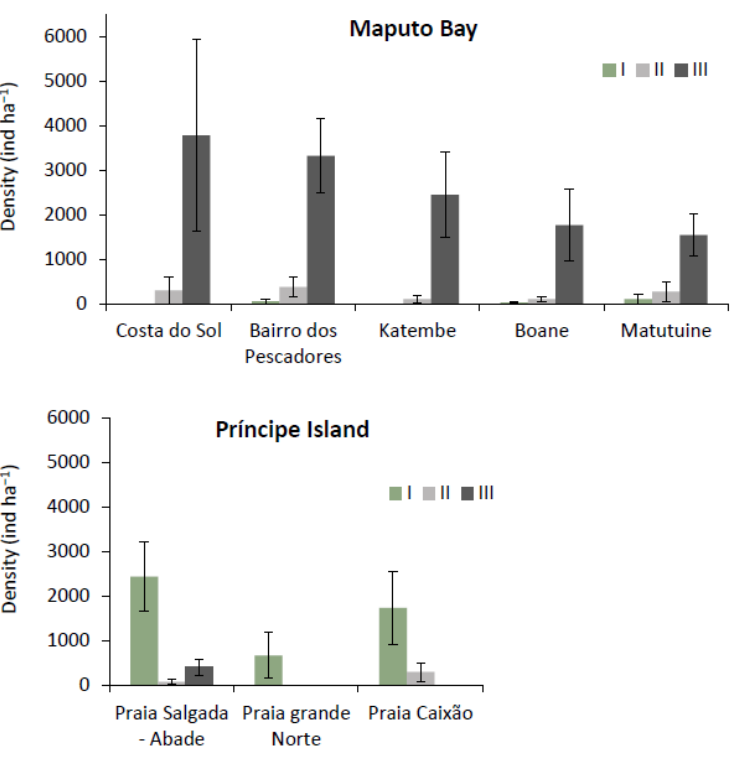
Figure 6. Density ( ± SE) according to stem quality classes in Maputo Bay and Pr í ncipe Island. Class I, Figure 6. Density (± SE) according to stem quality classes in Maputo Bay and Príncipe Island. Class II and III, representing, straight poles, semi-straight, and curved poles, I, II and III, representing, straight poles, semi-straight, and curved poles, respectively.